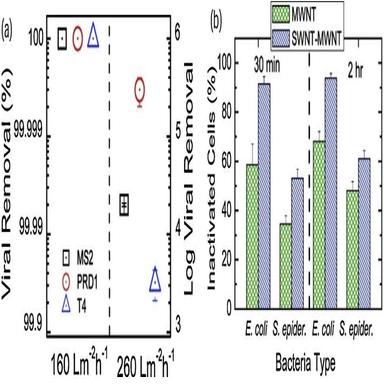
Schematic presentation of the working mechanism of CNT/PH nanofiber membrane for MD application .